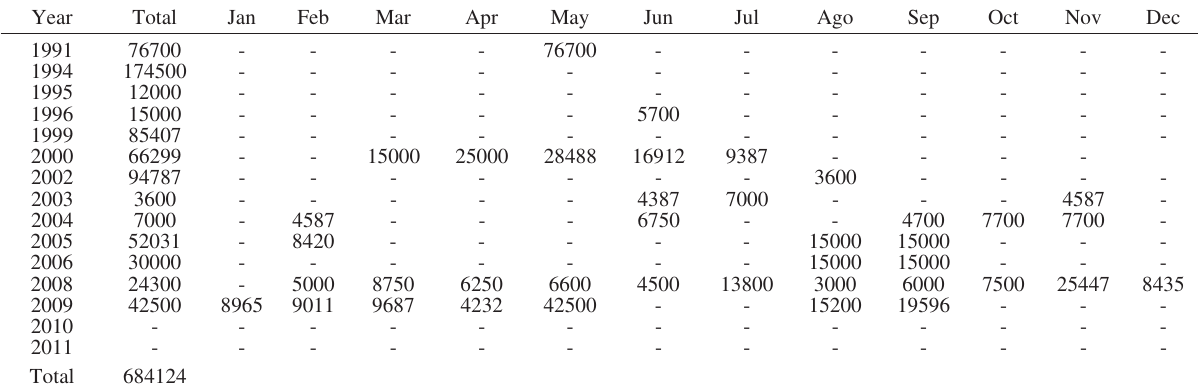
Table 1. – Sand mining (m 3 ) at the Valdevaqueros dune (updated from Muñoz-Perez et al. 2009).